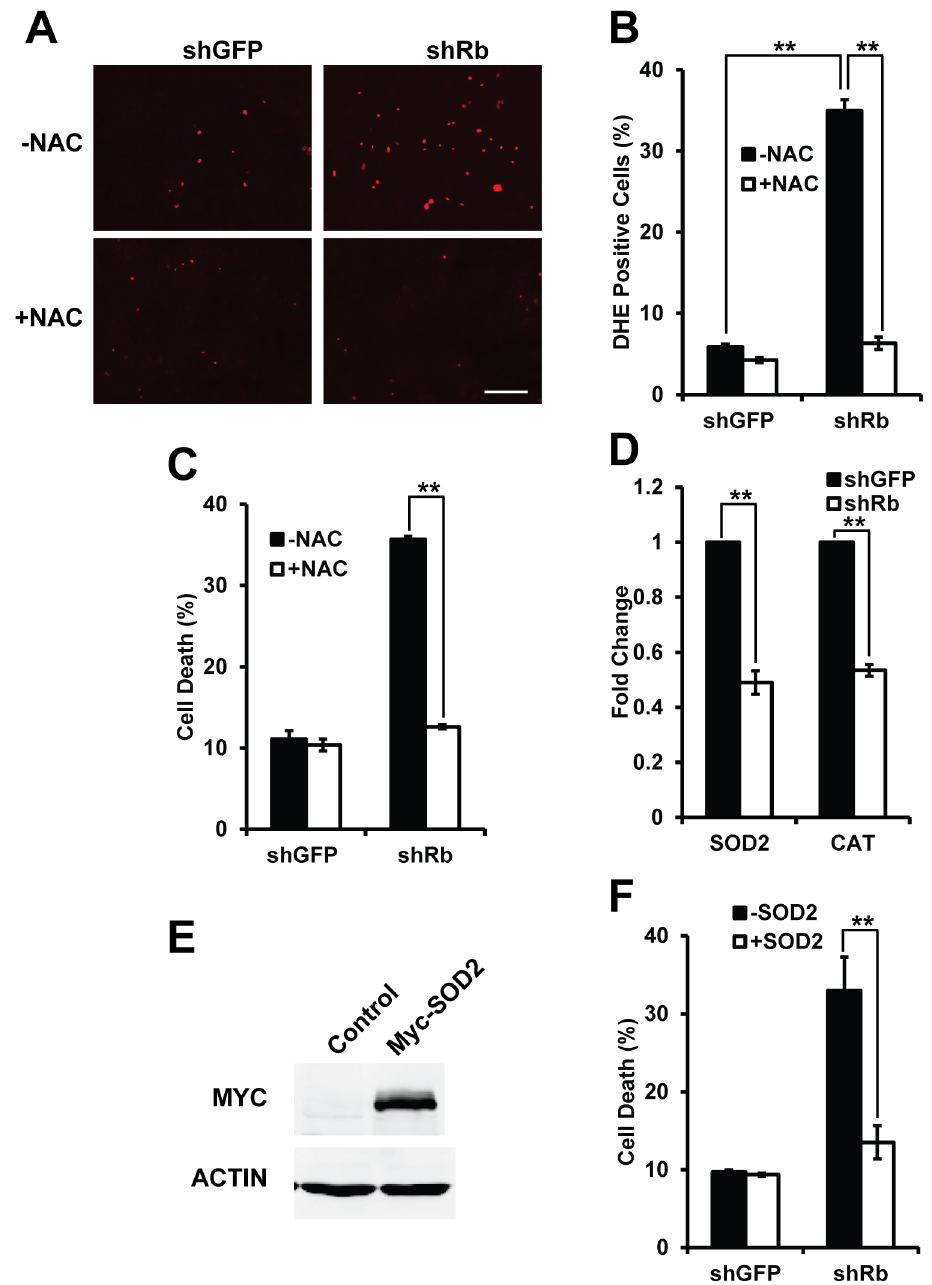
Fig 4. Oxidative stressinduced by knockdown of Rb caused the cell death in K1 cells. (A) Cell stained with Dihydroergotamine (DHE) showingincreasedDHE fluorescence in K1 cells with knockdown of Rb, and addingN-acetyl cysteine (NAC, 5mM) decreased the DHE signal. Scale bar, 100 μ m; (B) Quantification of the percentage of DHE positive cells in (A); (C) Cell death measuredby AnnexinV and PI assay showingadding NAC rescuedthe cell death in K1 cells with knockdown of Rb. (D) mRNA expression of SOD2 and Catalase (CAT) relative to the level of GAPDH in K1 cells with knockdown of Rb. (E) Immuno blot showed overexpression of SOD2. Actin serves as a loadingcontrol; (F) Cell death measuredby AnnexinV and PI assay showingoverexpression of SOD2 rescuedthe cell death in K1 cells with knockdown of Rb. ** < 0.01.